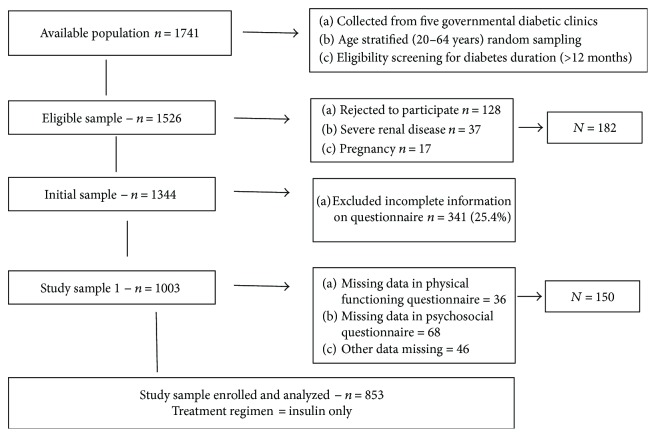
Recruitment process and the study.